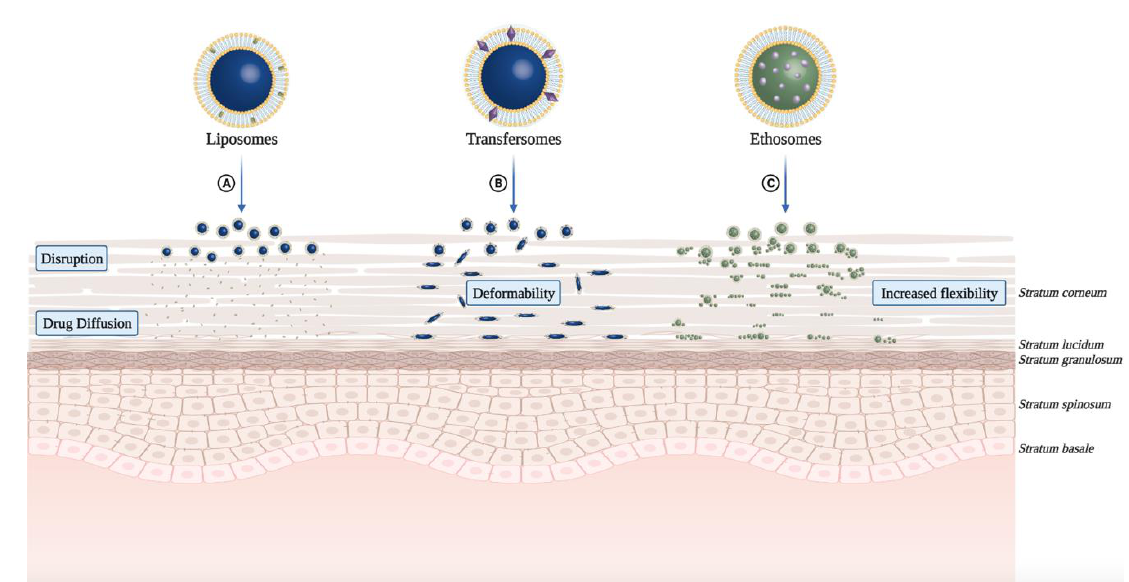
Figure 3. Mechanisms of skin permeation of lipid-based nano-vesicular systems for transdermal drug delivery in photodynamic therapy. ( A ) Conventional liposomes are superficially retained in the stratum corneum , disrupting and releasing the drug, which continues the epidermal penetration through diffusion. ( B ) Transfersomes have edge activators (surfactants) in their composition, which confer deformability, allowing for deeper drug release in the skin. ( C ) Ethosomes have a higher concentration of ethanol in their composition, increasing their flexibility and allowing for deeper drug release in the skin.